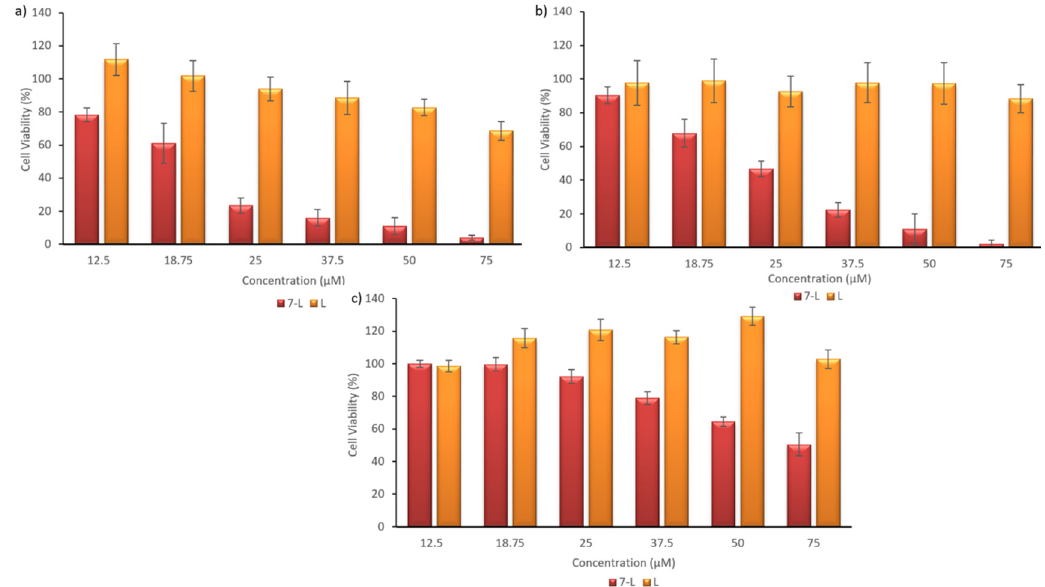
Figure 3. Pancreatic cell viability assessed by the MTT assay. Concentration–cell viability curves for ( a ) AsPC1 ( b ) BxPC3 and NHDF ( c ) cells treated with different amounts of (7) loaded liposomes (7-L) and control vesicles without drug (L) for 72 h.